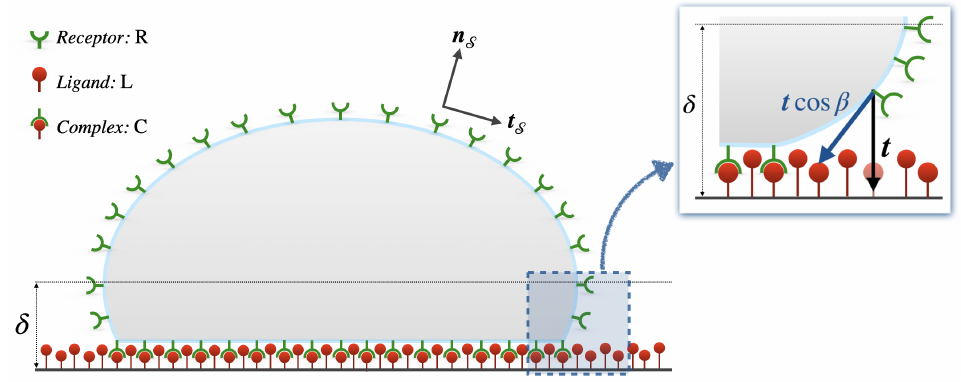
Figure 1. Schematic of an adherent cell onto an enriched ligands substrate, inspired by [25,26]. The image depicts the concept formulated within the adhesion traction model. Vectors n S and t S represent the normal and the tangent vector at a certain location on the cell membrane, respectively. Within the cutoff limit δ , the tangential component t cos β of the traction exerted by ligands (vertical traction t ), attracts the receptors on the cell membrane, generating an additive flux term, h T R , appearing in Equation (3). β is the angle with respect to the vertical defined by t